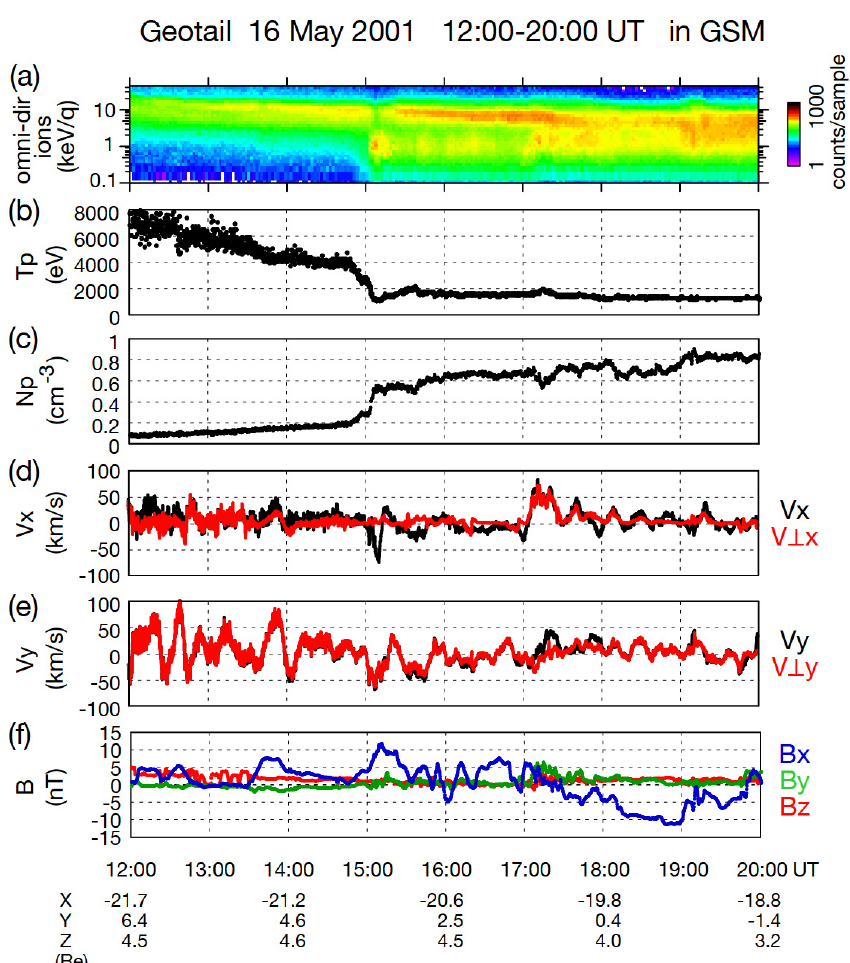
Fig. 1. Geotail observation between 12:00–20:00 UT on 16 May 2001. From the top, (a) energy-time (E-t) spectrogram of protons (omni- directional summation of 2-D data) in keV/q, (b) proton temperature in eV, (c) proton density in cm − 3 , (d, e) X and Y components of bulk velocity, and (f) three components of the magnetic field are shown. Bulk velocity is shown by black lines, and velocity perpendicular to the local magnetic field are shown by red lines. Locations of the spacecraft in the GSM coordinates are written at the bottom of the